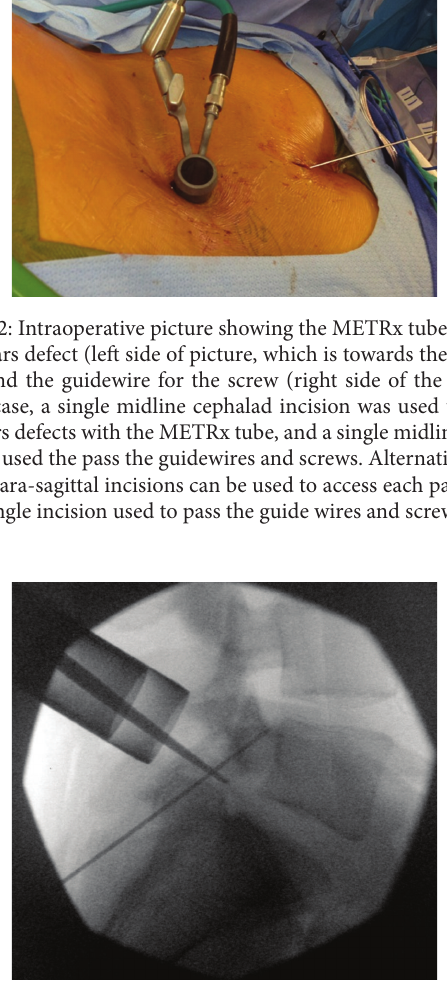
Figure 3: An 18mm METRx tube was then directed towards the pars defect using fluoroscopy. The pars defect was decorticated with a high-speed drill, and local autograft and BMP were placed in the defect. Note that this step is done prior to placing the wire. This fluoroscopy image shows a currete in the pars defect after it is prepared with the